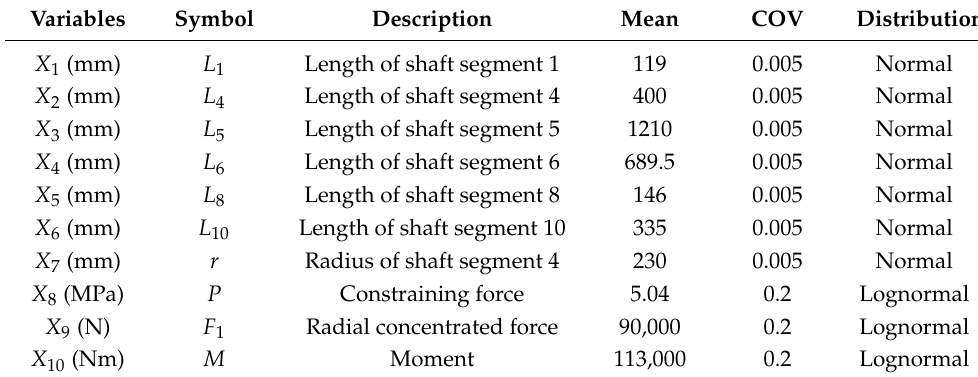
Table 6. Statistical information for the random variables in Example 3.